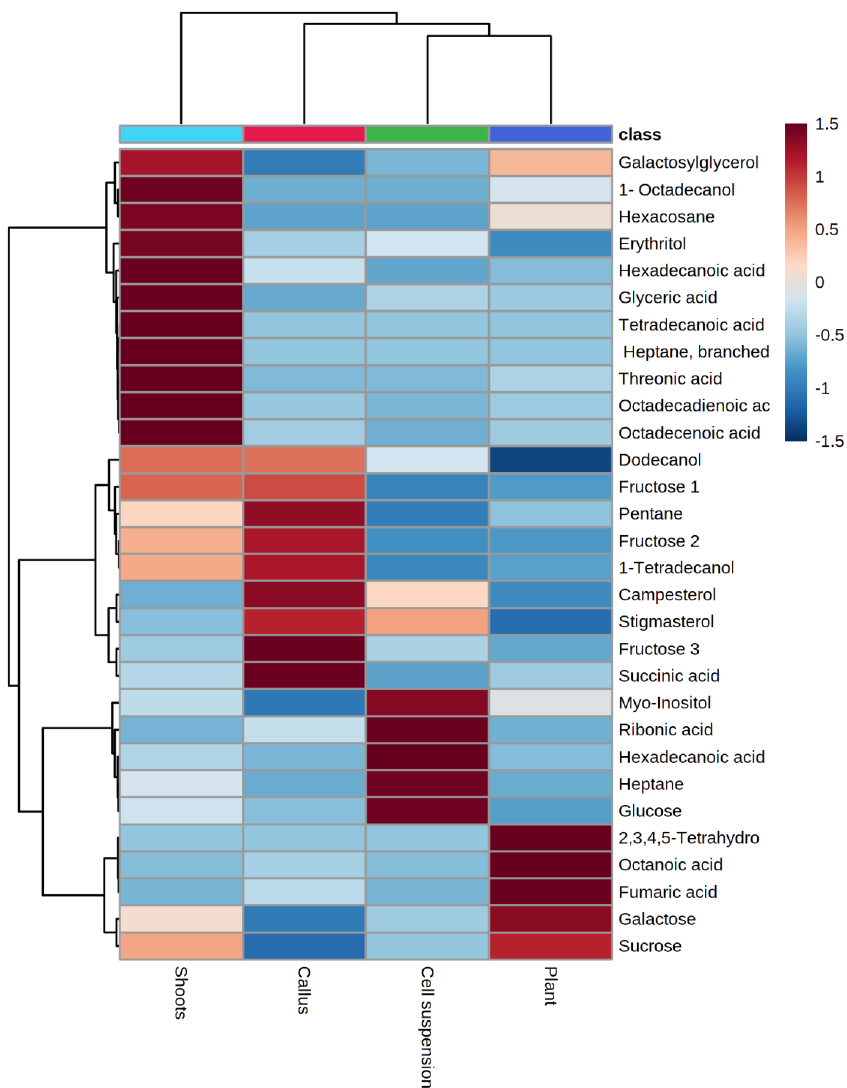
Figure 3. Hierarchically clustered heatmap of 30 most significant (T-test/ANOVA, n = 3) metabolites found in G. jasminoides plant leaves (Purple) and in vitro grown shoots (light blue), callus (red), and cell suspension (green) cultures, identified and quantified by GC/MS. Clustering was performed by using the Ward method with Euclidean distance. Each column in the Heatmap analysis represents a sample (plant, shoots, callus, and cell suspensions), and each row indicates metabolite concentrations at their highest and lowest levels (ranging from +1.5 to − 1.5), coded in red and blue colors with different